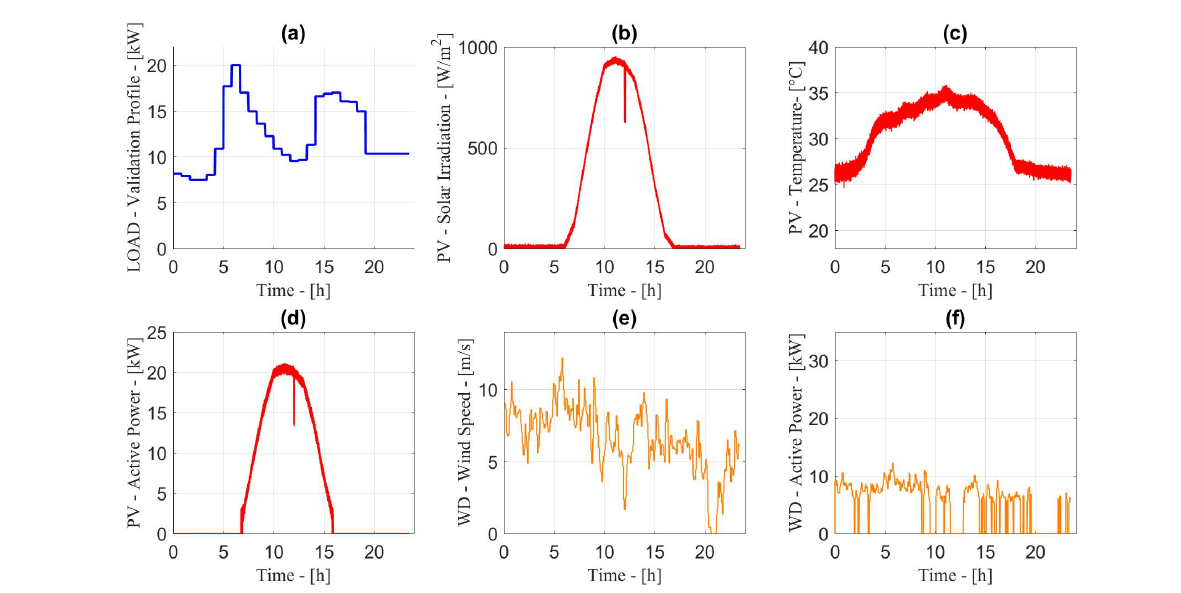
Figure 10. Load profile; ( a ) active power in kW. PV system; Inputs: ( b ) solar irradiance in W/m 2 and ( c ) temperature in °C. Output: ( d ) active power in kW. WD system; Input: ( e ) Wind speed in m/s. Output: ( f ) Active power in